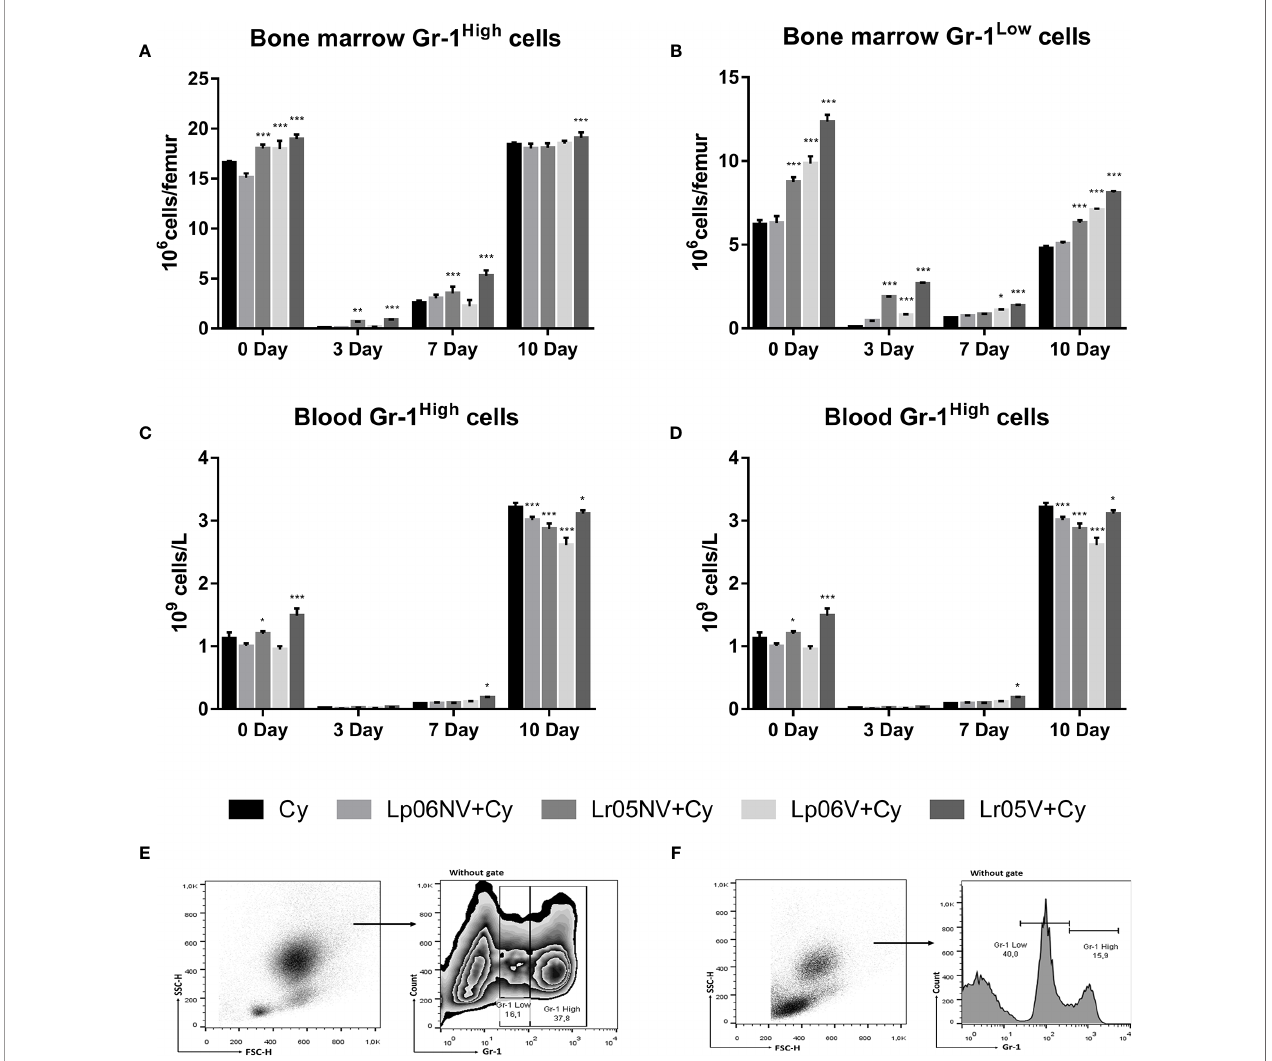
FIGURE 5 | Gr-1 expression in bone marrow and blood by fl ow cytometry. 6-week-old Swiss mice were fed with 10 8 cells/mouse/day of viable or non-viable Lactobacillus rhamnosus CRL1505 (Lr05V+Cy or Lr05NV+Cy groups) or L. plantarum CRL1506 (Lp06V+Cy or Lp06NV+Cy groups) for 5 consecutive days before injection of Cy. The treated groups and the untreated control mice (Cy group) received one dose of 150 mg/kg Cy intraperitoneally. Bone marrow Gr-1 High cells (A) , and Gr-1 Low cells (B) , blood Gr-1 High cells (C) , and Gr-1 Low cells (D) were performed on day 0, before Cy administration, and days 3, 7 and 10 post-Cy administration. The results come from two independent experiments. Six animals per group each time were used in the experiments. Results are expressed as mean ± SD. ***,**,* Signi fi cant differences from the Cy group should be as follows (p<0.0001, p<0.002 or p< 0.02 respectively). Gating strategy to study Gr-1 High and Gr-1 Low cells in bone marrow (E) , and in blood (F) ( Figure 5 ). We decided to continue the assays of myeloid maturation in BM with the viable and non-viable L. rhamnosus CRL1505.